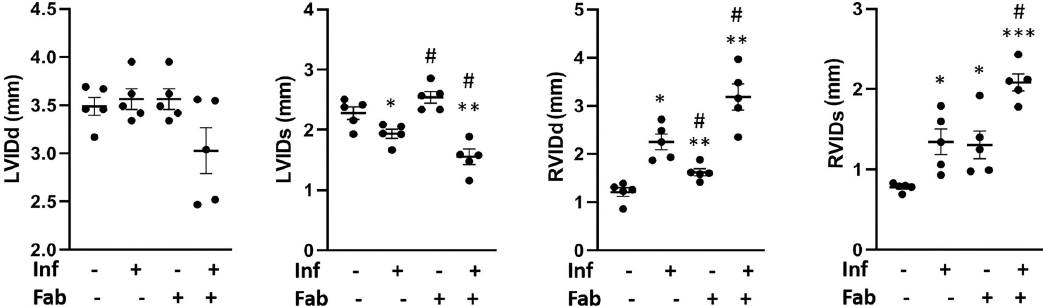
Fig 2. Loss in adipocytes increases cardiac enlargement during acute T . cruzi infection (30DPI). Left ventricle internal diameter (LVID) and right ventricle internal diameter (RVID), measured by ultrasound analysis of the hearts both at diastole (d) and systole (s) conditions at 30 DPI, in infected or uninfected mice, fat-ablated (Fab +) or fat-unablated (Fab-) mice as indicated. The error bars represent SEM. � p � 0.05, �� p � 0.01 or ��� p � 0.001 compared with uninfected fat-unablated. # p � 0.05 compared with infected fat-